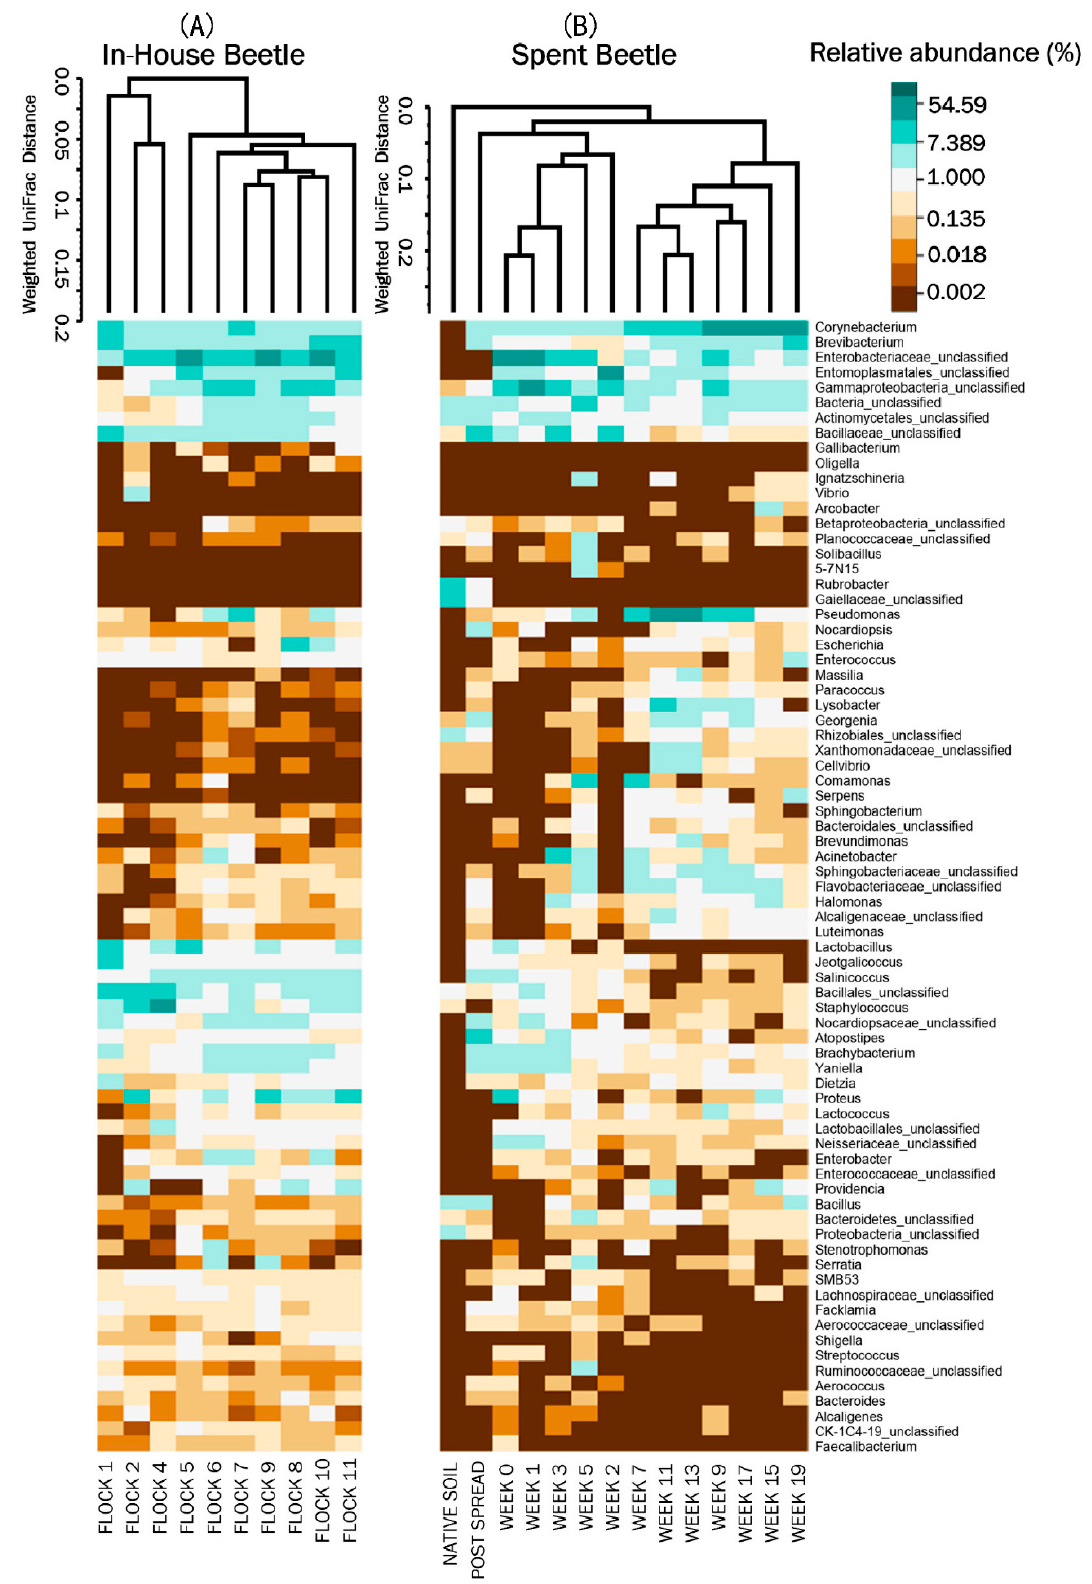
Figure 3. Heatmaps of the top 75 bacterial genera associated with LM during the ( A ) In-House Beetles associated with flock rotations; and ( B ) subsequent pastureland application of the Spent Beetle samples. In-House and Spent Beetle were clustered using Weighted Pair Group Method with Arithmetic Mean (UPGMA) tree based on weighted Unifrac distances. For natural log transformation “0” was converted to “0.01”. n = 8 composite samples/Flock and 1 composite